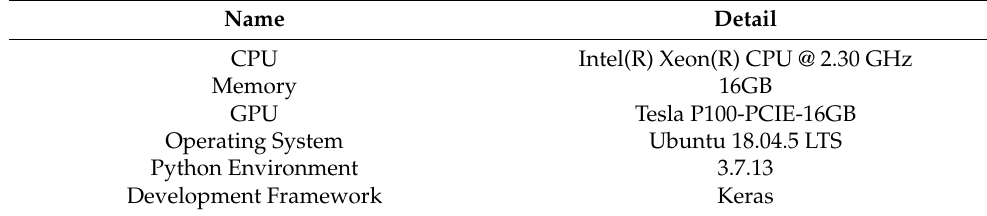
Table 2. The configuration of